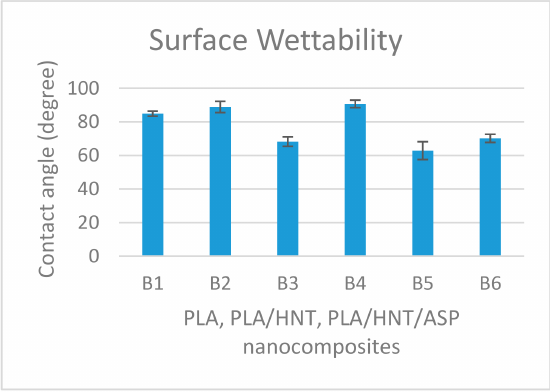
Figure 8. Graphical representation of contact angle measurements for all batches indicates the hydrophilicity nature of B5 and B3 batch of 2:1 ratio of both preloading and matrix-loading which is comparable to native PLA which has a contact angle of 70 ◦ . The B1 and B2 samples with a 1:1 ratio tend to be hydrophobic, exhibiting a contact angle of ca. 90 ◦ .